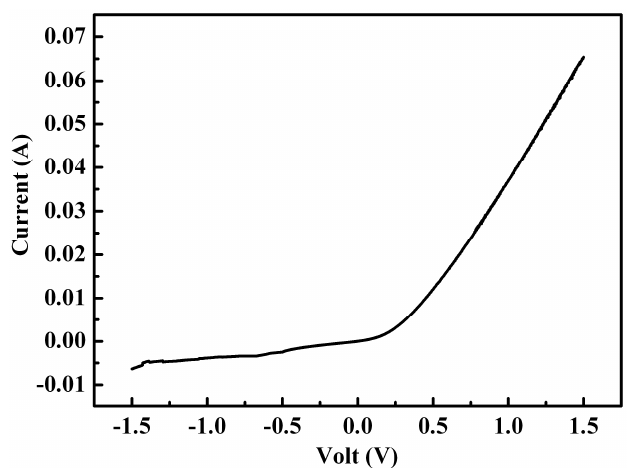
Figure 10. Dark I-V curve of a ZnS/AlSb:Zn thin film solar cell.